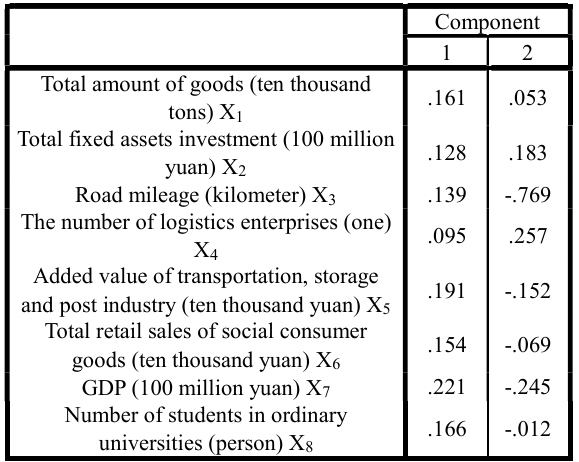
Table 3-3 Component score coefficient